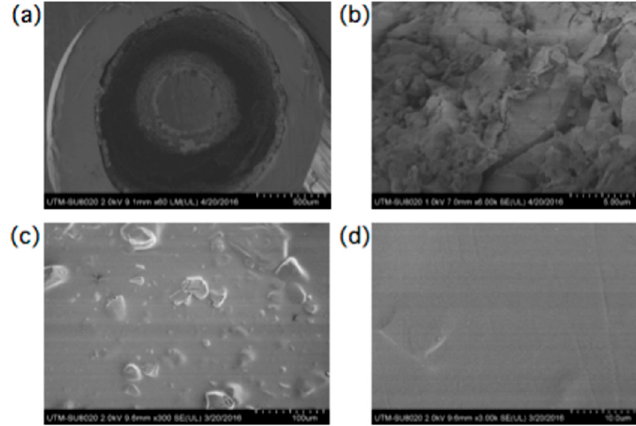
Figure 3. Field-emission SEM images of the C 18 -mixed matrix membrane tip device: ( a ) overall tip structure (top view); ( b ) cross-section image of membrane; ( c ) outer surface image of membrane; ( d ) inner surface image of membrane.